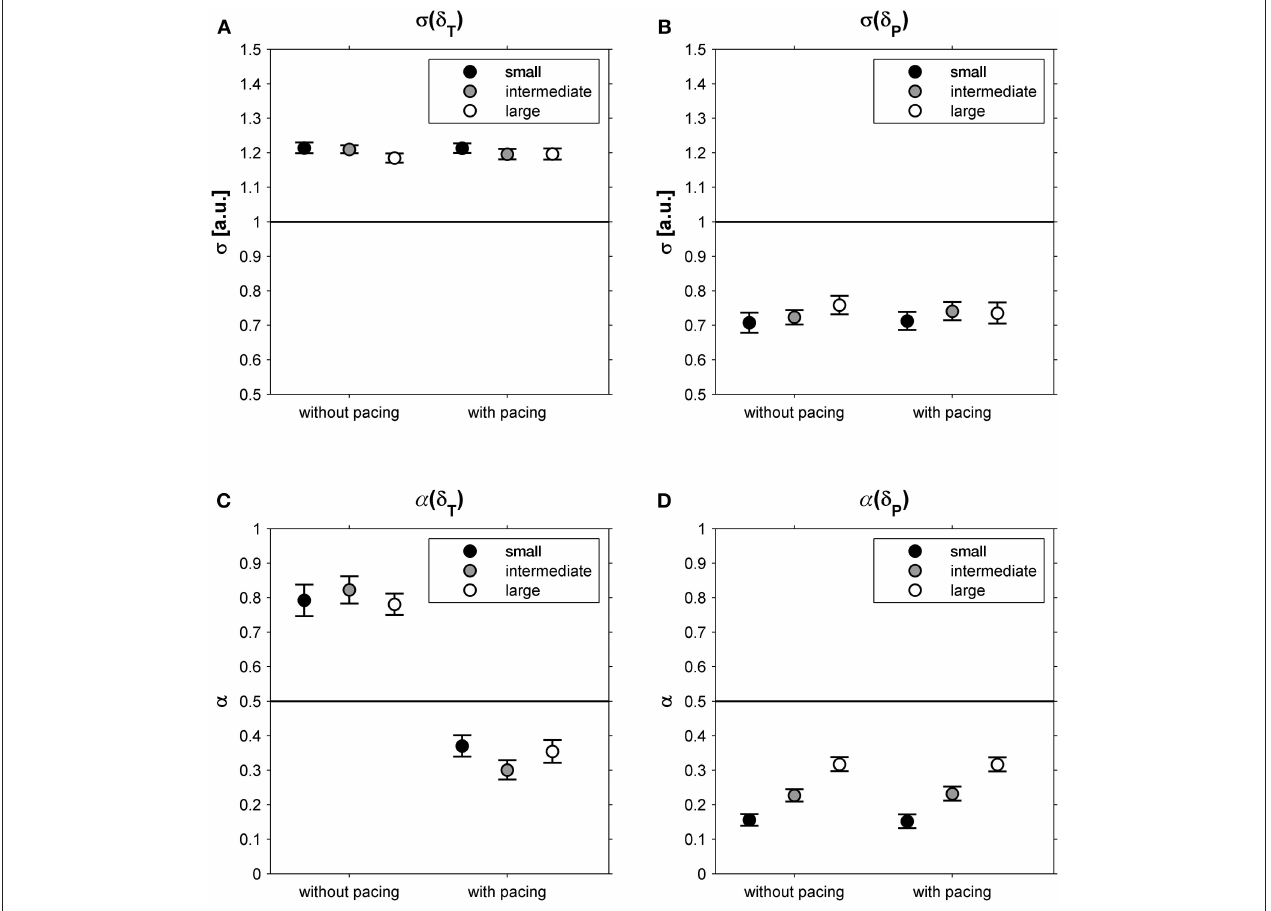
FIGURE 4 | Relative standard deviations ( σ ) for deviations tangential ( δ T ; A ) and perpendicular ( δ P ; B ) to the constant-speed GEM, depicted as a function of Pacing and Walking Area. In (C,D) , the corresponding DFA scaling exponents α are shown for these conditions. Error bars represent standard